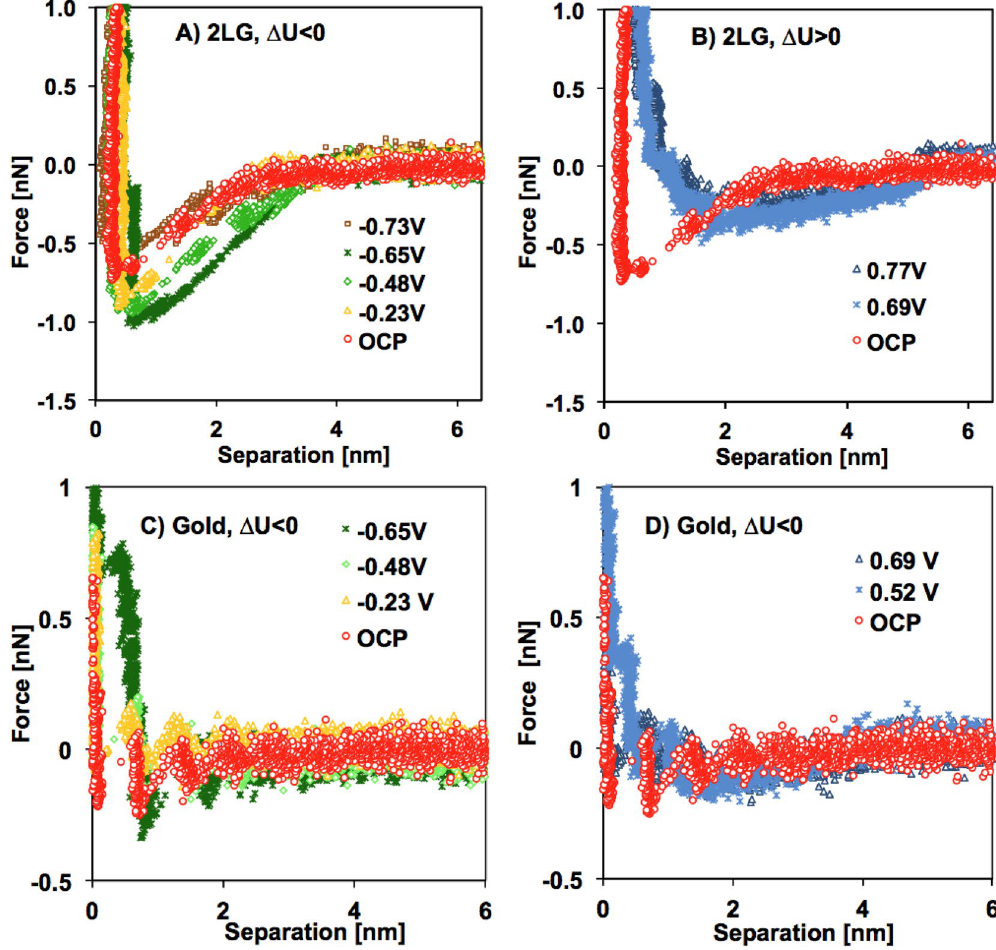
Figure 2. Selected force-separation curves for gold-supported bilayer graphene ( A , B ) and gold ( C,D ) at negative ( A , C ) and positive ( B , D ) potentials measured with an AFM tip. Spring constant of cantilever = 0.375 N/m and silicon tip with radius = 20 nm. Note the different minimum value of the